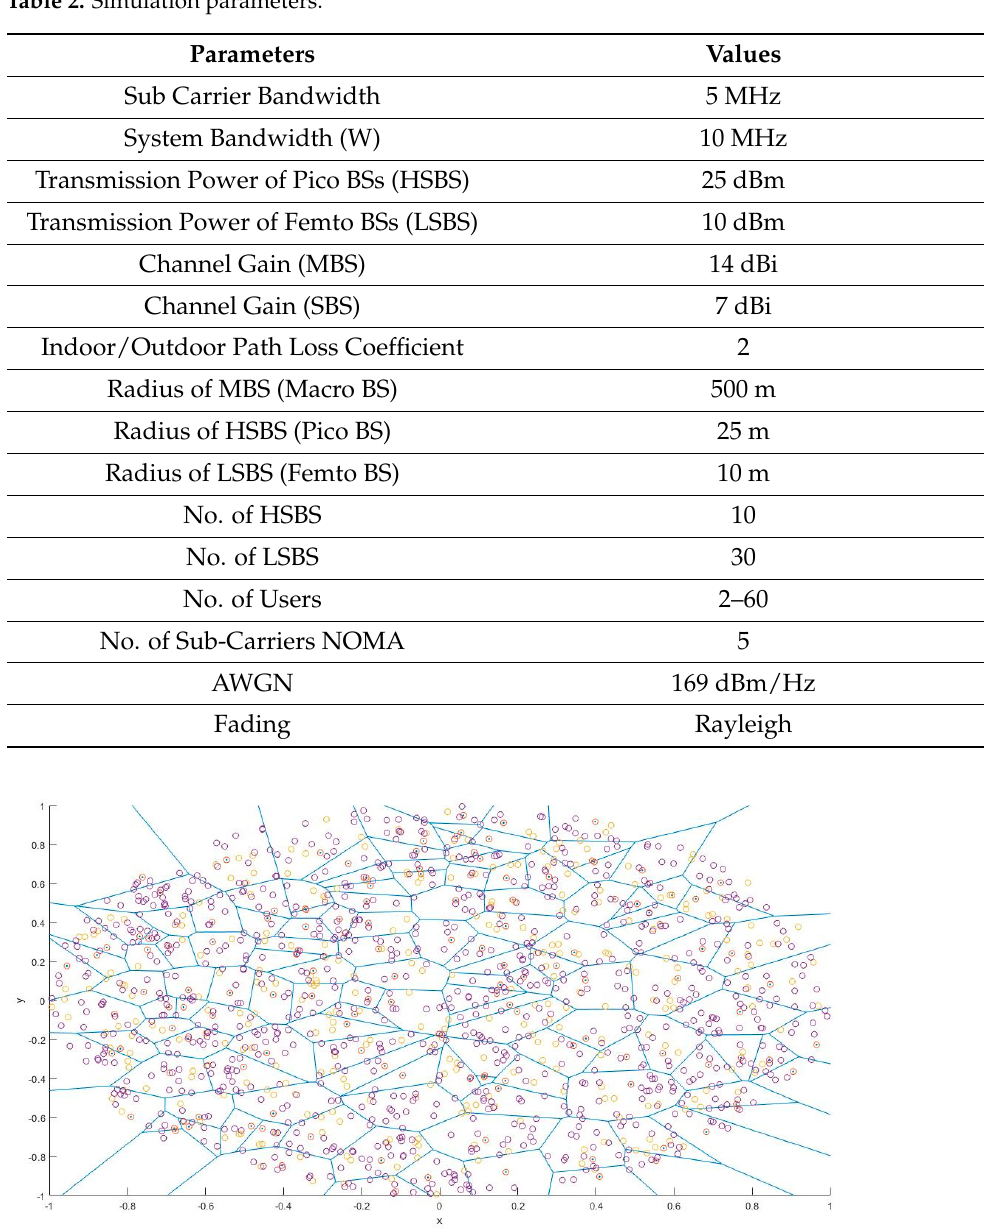
Table 2. Simulation parameters.